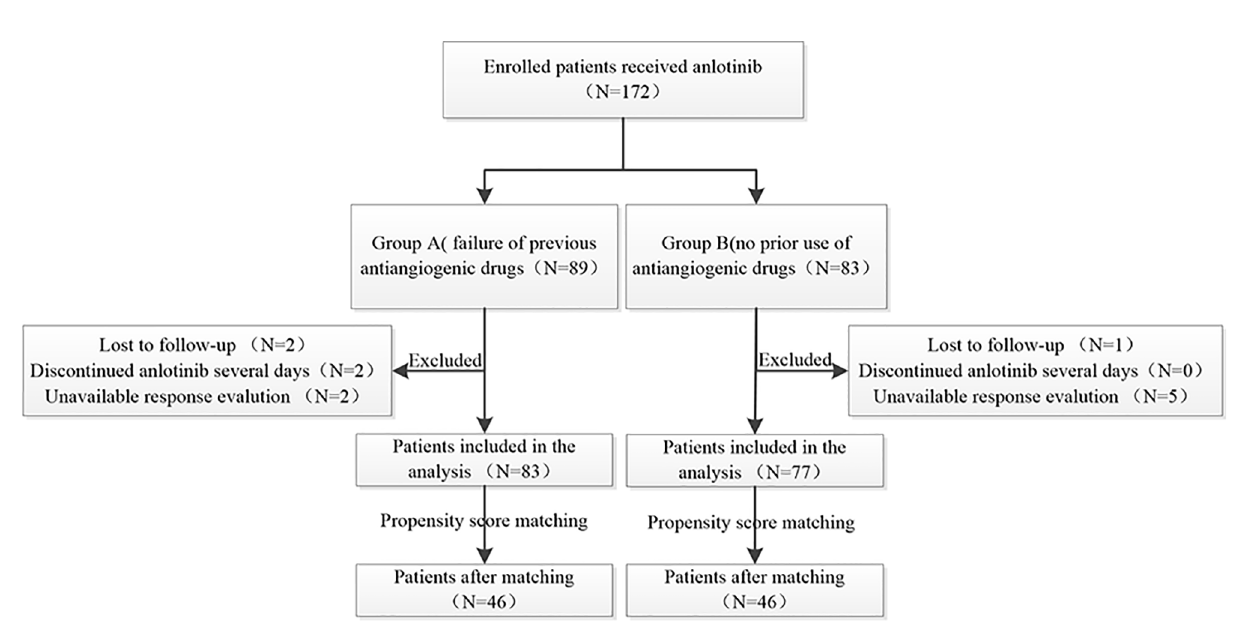
FIGURE 1 | The research fl ow